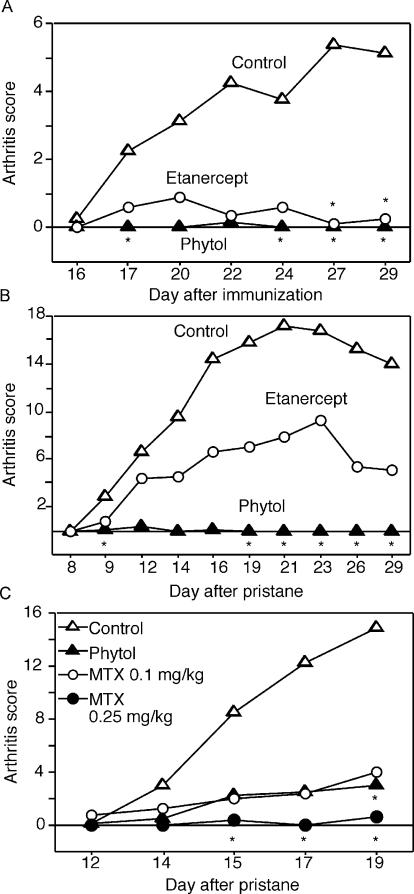
Phytol Is as Effective as or More Effective than Standard Treatments for RA(A, B) Comparison of efficacy of phytol and etanercept in (A) CIA (n = 8) and (B) PIA (n = 7) in DA.Ncf1
DA rats. 200 μl of phytol and 0.4 mg/kg etanercept in a total volume of 200 μl was injected (SC) on days 8, 10, and 12 after disease induction.(C) Efficacy of phytol and MTX. MTX (IP) and phytol (SC) was injected on days 8, 10, and 12 (control n = 9, phytol n = 9 and MTX n = 5) after PIA induction in DA.Ncf1
DA rats.*p < 0.05.